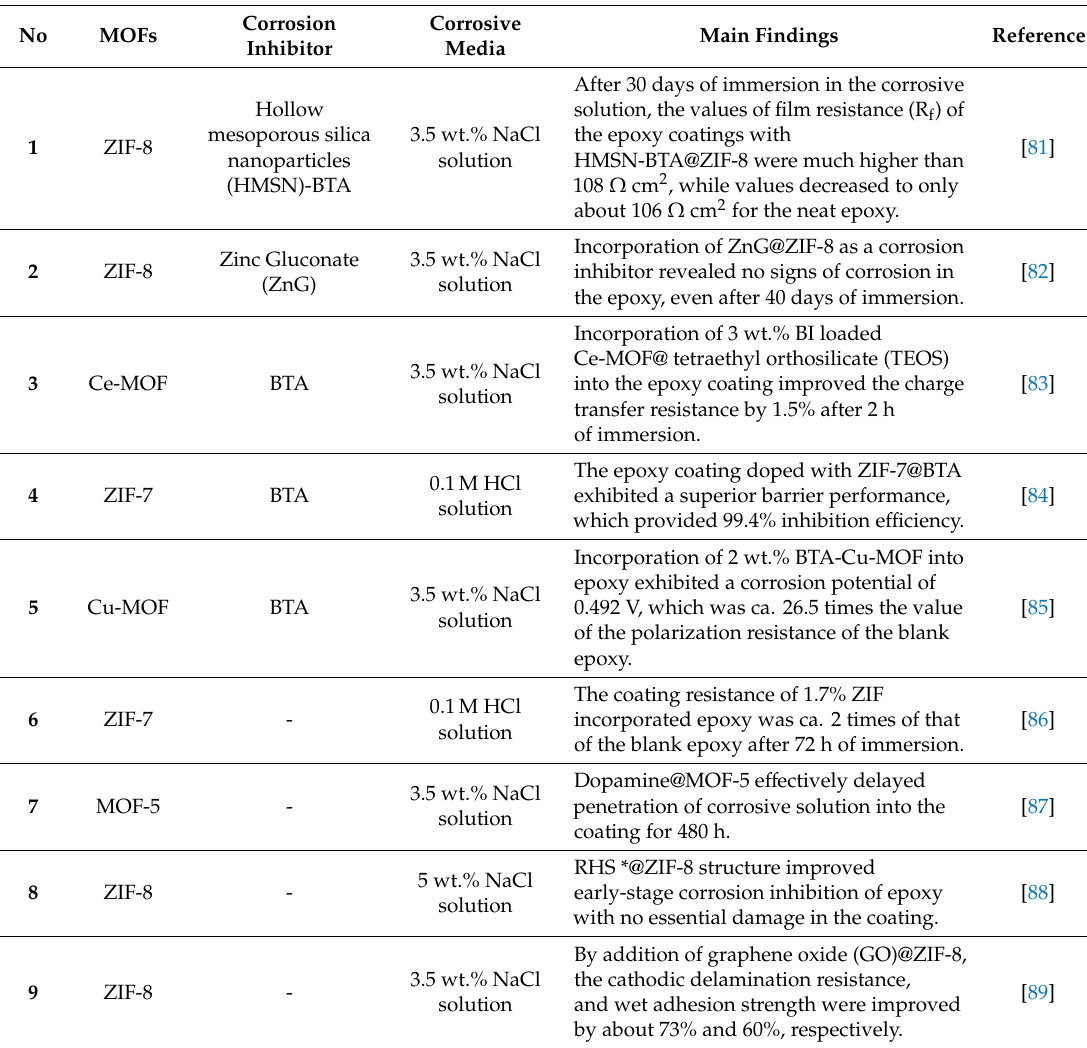
Table 1. Epoxy / MOF nanocomposites applied as coatings, with satisfying anti-corrosion properties. The main outcomes of recent research are also provided. Di ff erent types of MOFs applied in coating technology are summarized in the following table, such as Cu-MOF [76] and ZIF-8 / ZIF-7 [77,78]; Ce-MOFs [79], and MOF-5 [80] made of Cu (II) and Zn (II) as the nodes, and benzotriazole (BTA), 2-methylimidazole / benzotriazole (BIM), 2-methylimidazole, BTA, and terephthalic acid (H 2 BDC), respectively, as the organic